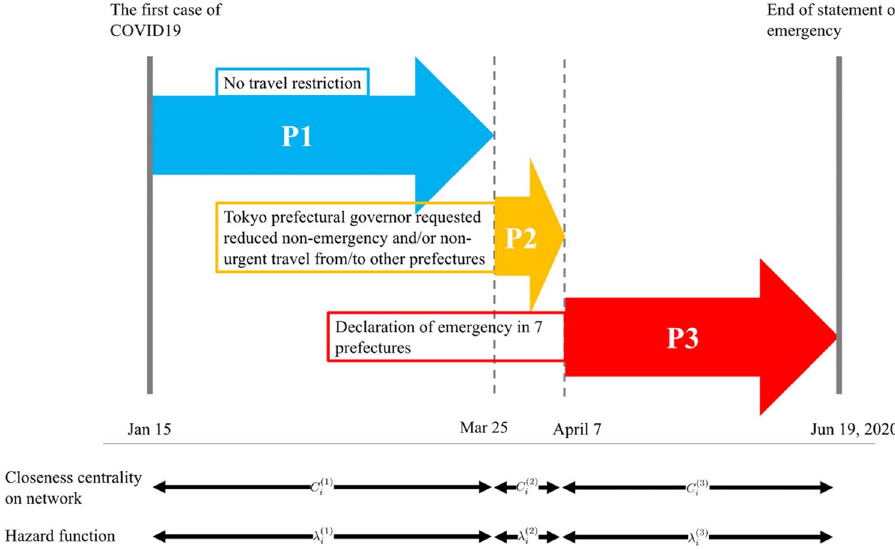
Figure 3. Timeline of study and associated